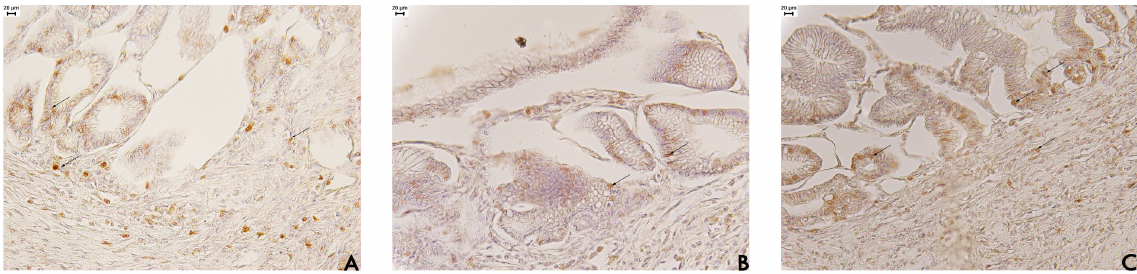
Figure 3. Photomicrography of histological analyses of stomach of rat treated orally with ( A ) vehicle (10 mL/kg); ( B ) cimetidine (100 mg/kg); and ( C ) acetate fraction of Alchornea triplinervia (100 mg/kg). The scale represents 20 µm and arrows denote nucleus PCNA positive by peroxidase